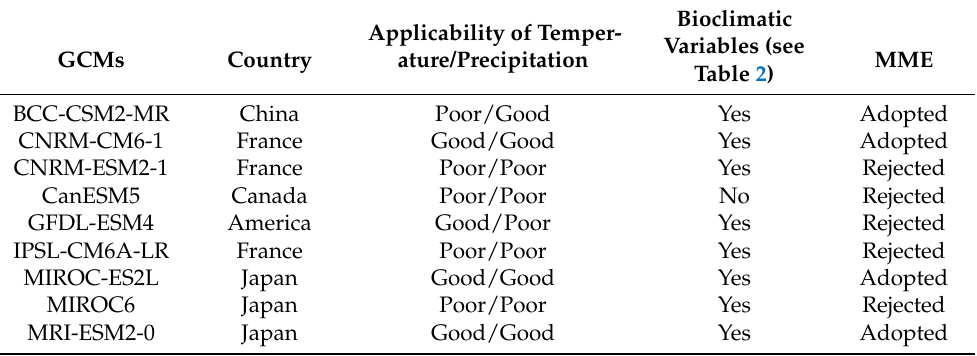
Table 1. The basic information of 9 climate models of CMIP6 and their applicability in China. Based on the assessments of Taylor plot or other methods for temperature/precipitation in the relevant literature, “poor” indicates that the simulation capacity of the climate model is below 50% compared to all models of literature, and “good” indicates that of above 50%.